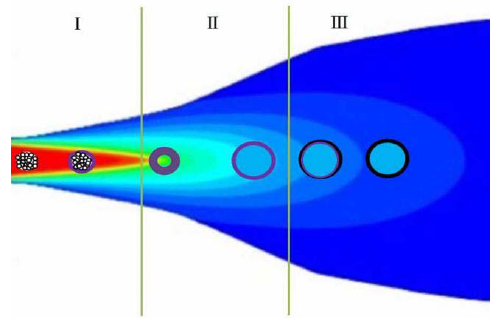
Figure 7. Evolution of a particle in the plasma flame.